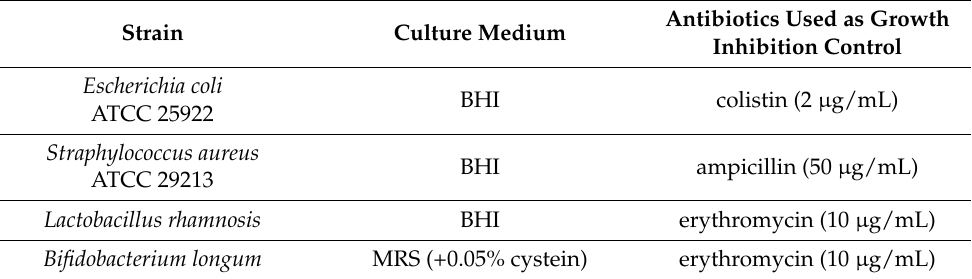
Table 2. Table 2. Culture medium and antibiotic used as growth inhibition control for included bacterial bacterial strains.